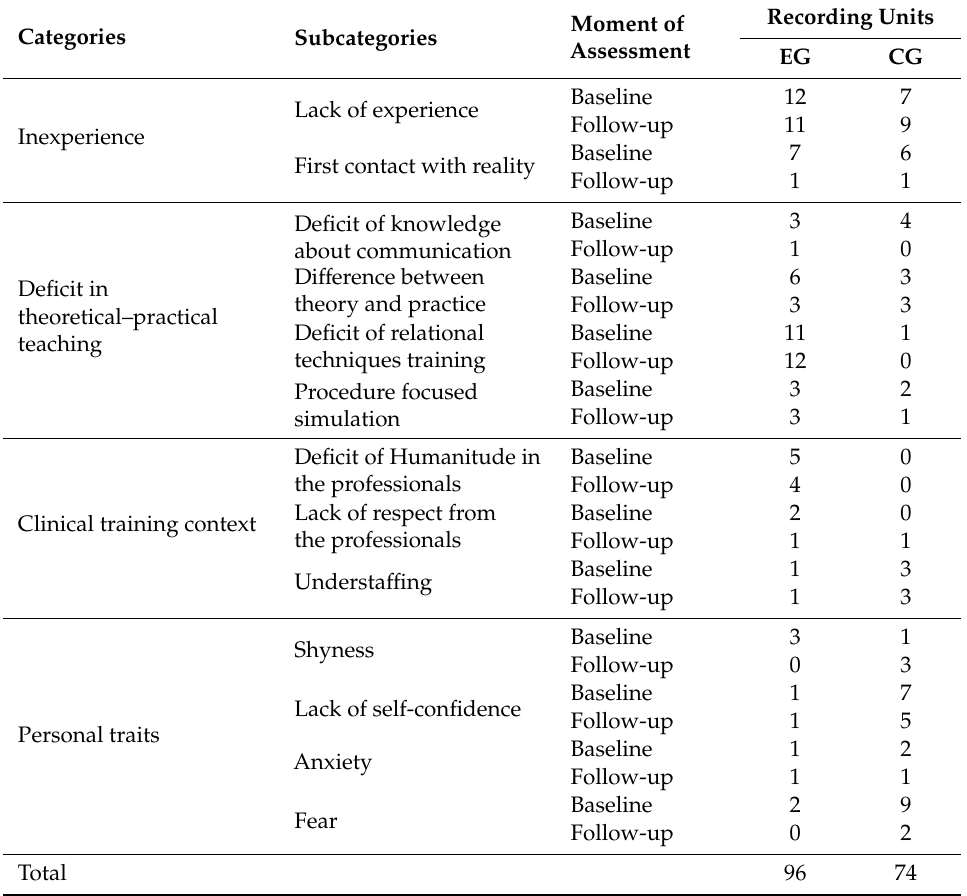
Table 2. Causes of the di ffi culties experienced by EG and CG students at baseline and follow-up. Moment of Categories Subcategories Lack of Inexperience